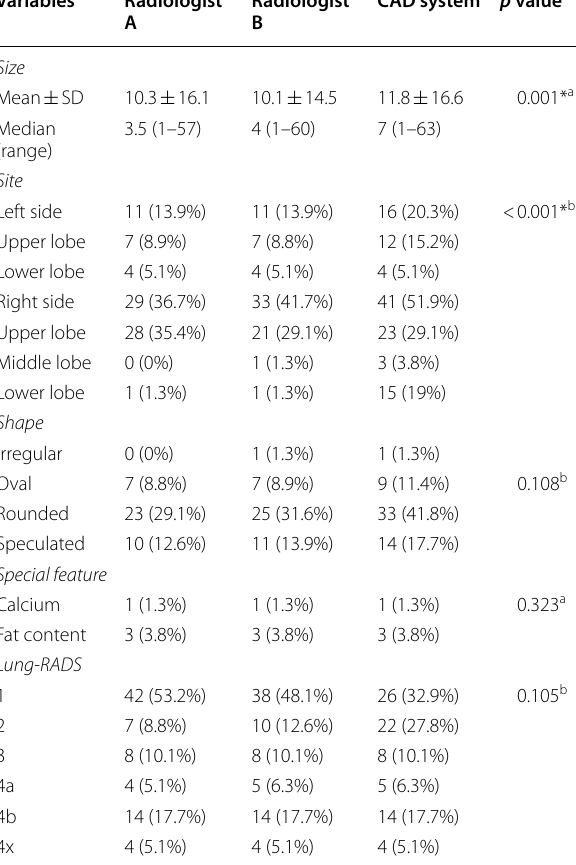
Table 4 Comparison between nodules type and size as 79) described by final CAD system and the reference =